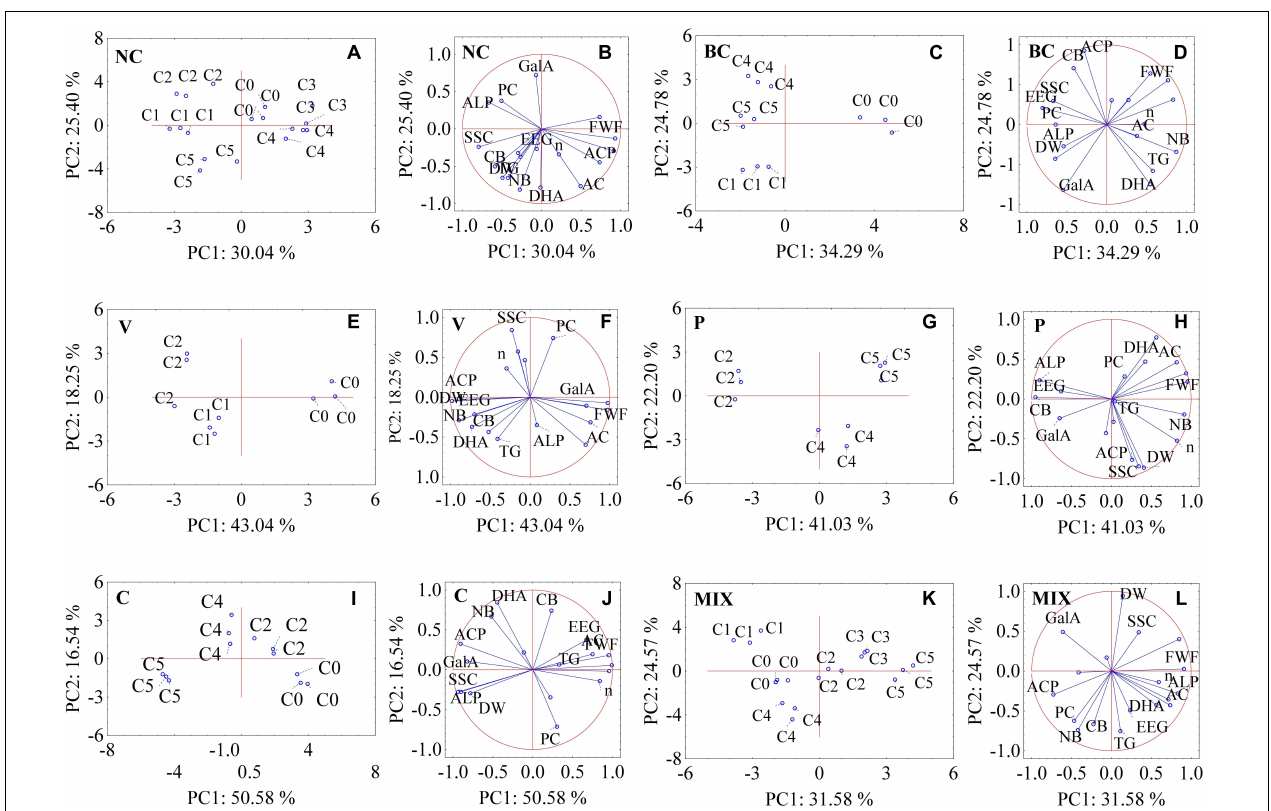
FIGURE 3 | Principal component analysis (PCA) showing interrelation of microbiological consortia used and quality parameters of strawberry fruit and soil. (A,B) NC (no contamination), (C,D) BC ( B. cinerea ), (E,F) V ( Verticillium sp.), (G,H) P ( Phytophthora sp.), (I,J) C ( Colletotrichum sp.), (K,L) MIX (pathogen group: BC, V, P, C.); C0, control (no bacterial consortia); C1, Consortium 1; C2, Consortium 2; C3, Consortium 3; C4, Consortium 4; C5, Consortium 5; FWF, fresh weight of fruit; DW, dry weight of fruit; SSC, soluble solid content; PC, content of phenolic compounds; AC, content of anthocyanins; GalA, content of D-galacturonic acid; n, viscosity; TG, total glomalin; EEG, easily extractable glomalin; DHA, dehydrogenase activity; ACP, acid phosphatase activity; ALP, alkaline phosphatase activity; CB, carbon inbiomass; NB, nitrogen in